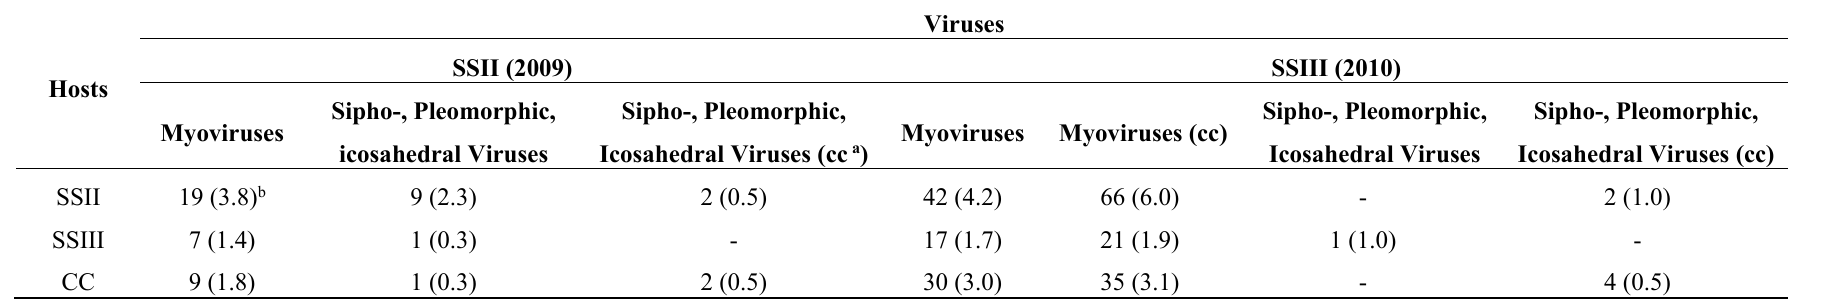
Table 3. The number of virus-host interactions according to isolation year, virus morphotype, and isolation